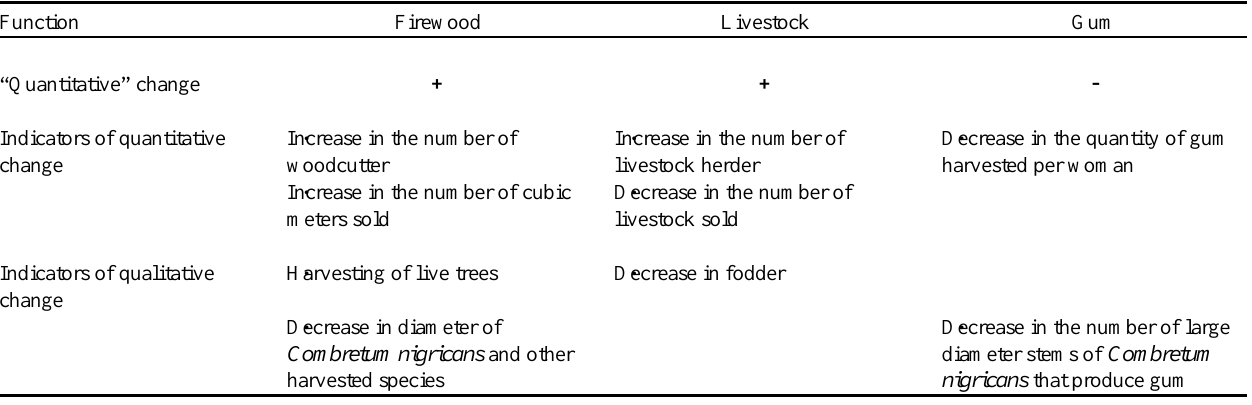
Table 2 . Changes in three social-ecological system functions in Ñinpelima.